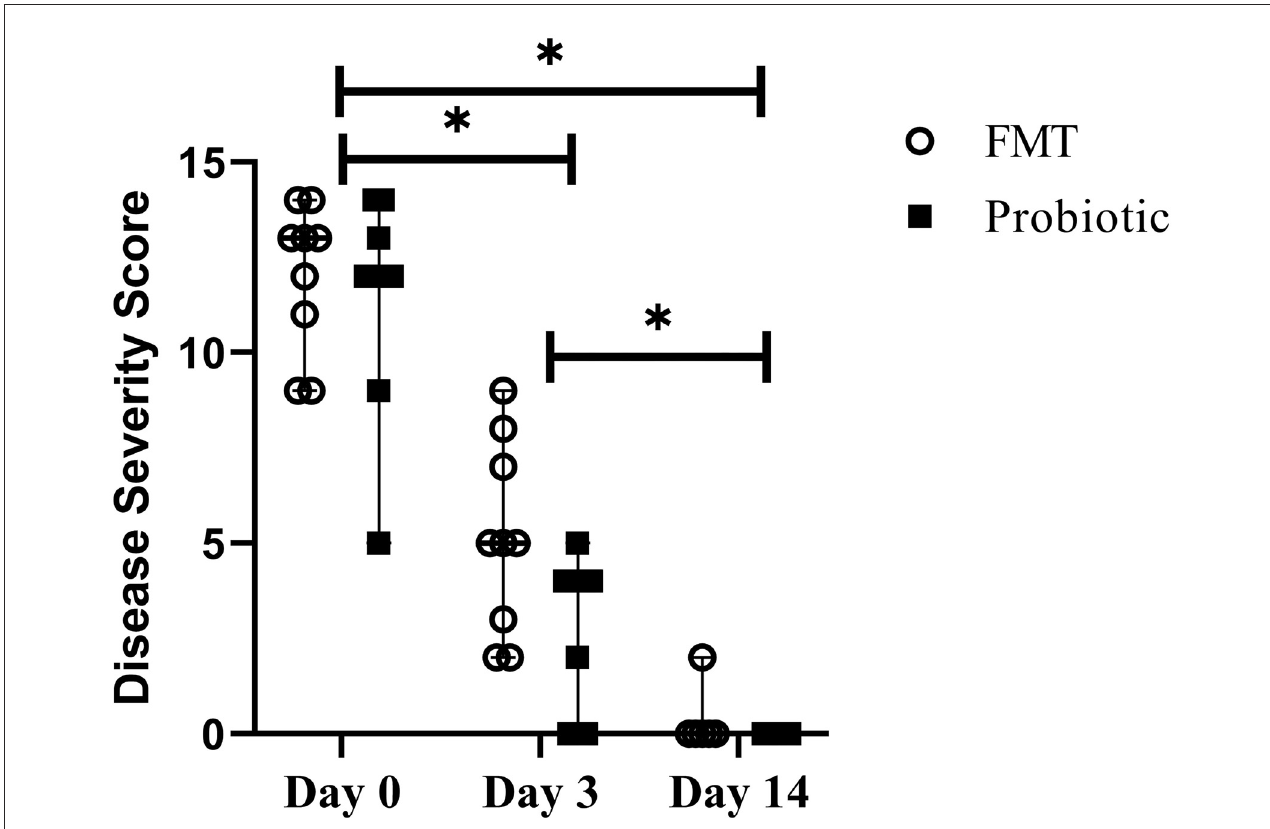
FIGURE4 Line plot of serial disease severity scores from 18 dogs with acute hemorrhagic diarrhea syndrome receiving either fecal microbiota transplant (FMT) or probiotic. Data are presented as median (range); data points represent individual dog values. Asterisk (*) indicates a significant difference ( p < 0.05) when comparing baseline vs. days 3 and 14 and day 3 vs. day 14 in all